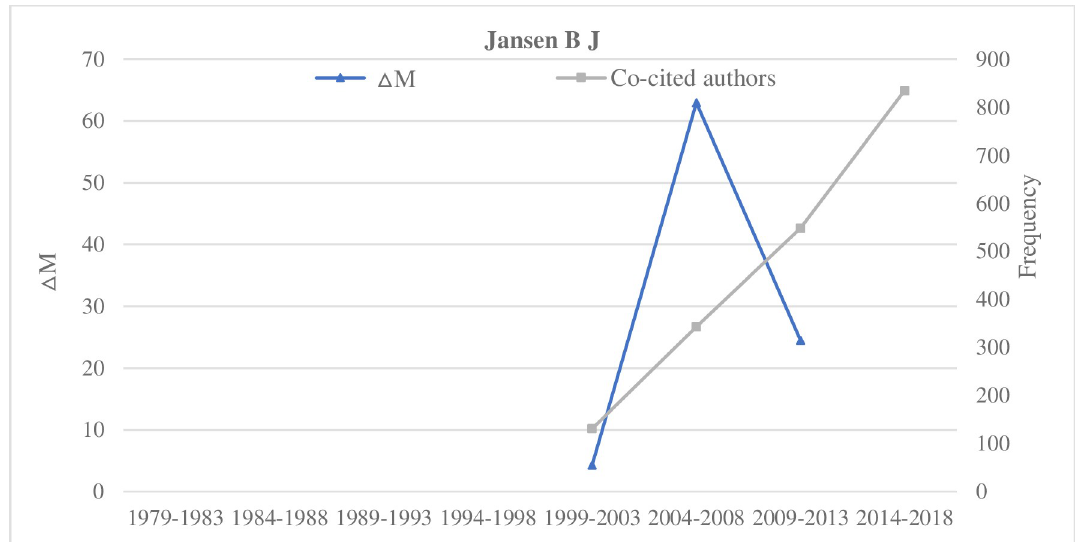
Fig 9. Indicators of the impact of Jansen B